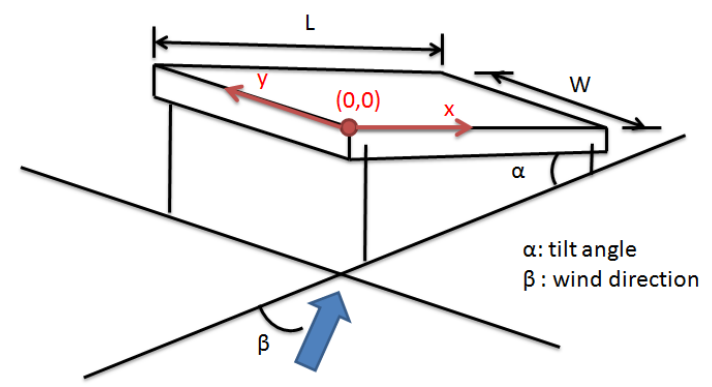
Figure 1. Test configuration for a stand-alone model.